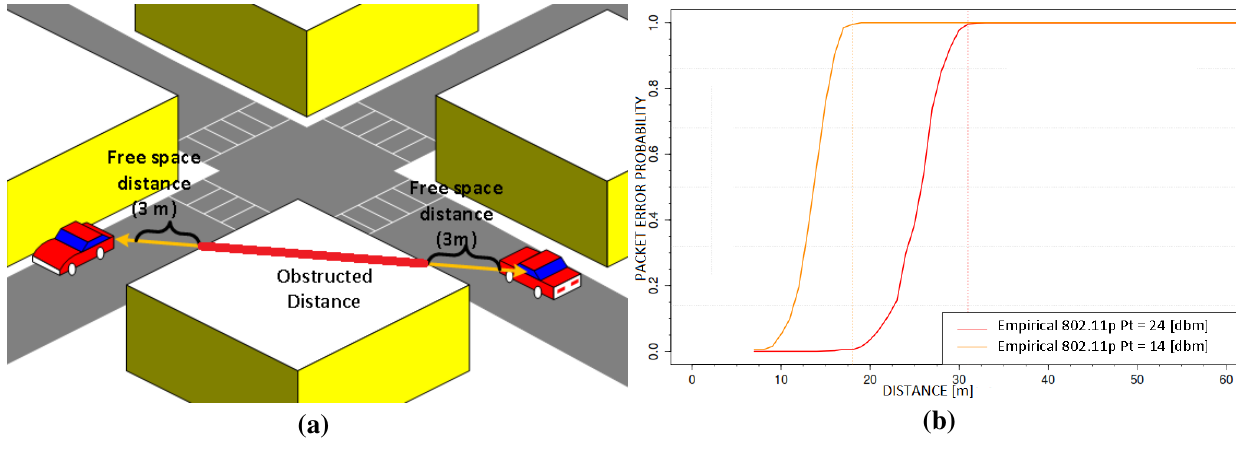
Figure 4. Packet error probability (PEP) behavior in an obstructed communication scenario between two vehicles near a corner. Empirical IEEE 802.11p channel model. Channel Capacity= 6 Mbps. Antenna sensitivity = − 82 dbm. ( a ) Near-line-of-sight (NLoS) scenario at a corner; ( b ) PEP vs .